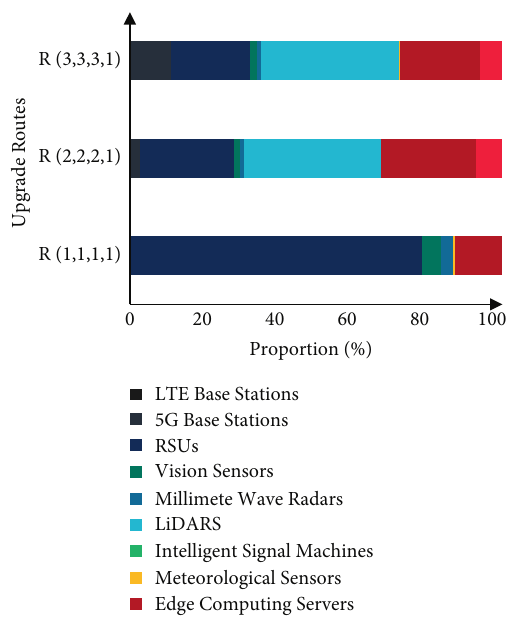
Figure 11: Share of cost components of one-time intelligent up- grade of transportation infrastructure in closed highway scenario.